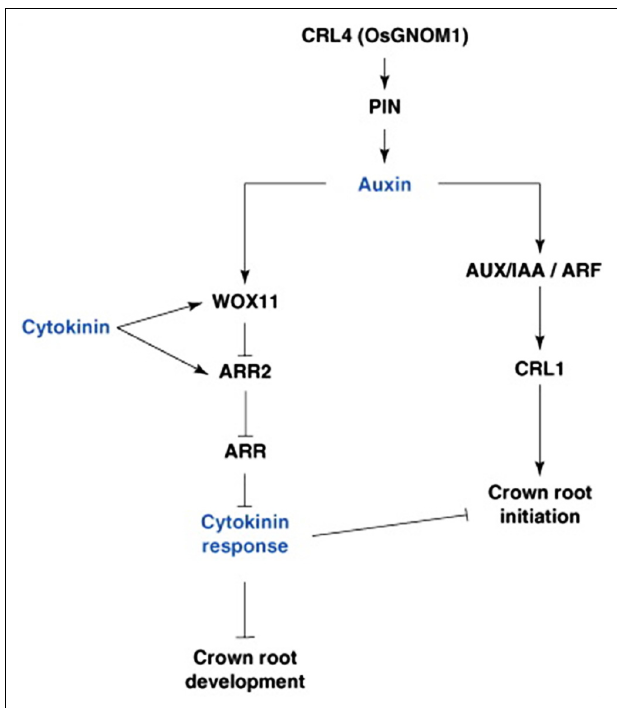
FIGURE 3 | Hormonal and genetic control of crown root formation in rice. Crown root initiation in rice is promoted by auxin, and regulated by the inhibitory influence of cytokinin. Arrows represent the positive regulatory action of one element of the network on another one. A line ending with a bar represents the negative regulatory action of one element of the network on another one. ARF, Auxin Response Factor; ARL, ARR, type-A RESPONSE REGULATOR; AUX/IAA, AUXIN/INDOLE-3-ACETIC ACID; CRL4, CROWN ROOTLESS4; GNOM1, GTP:GDP ANTIPORTER/PROTEIN HOMODIMERIZATION1; PIN1, PIN-FORMED1;WOX11,WUSHEL-Related Homeobox 1 (Coudert etal.,